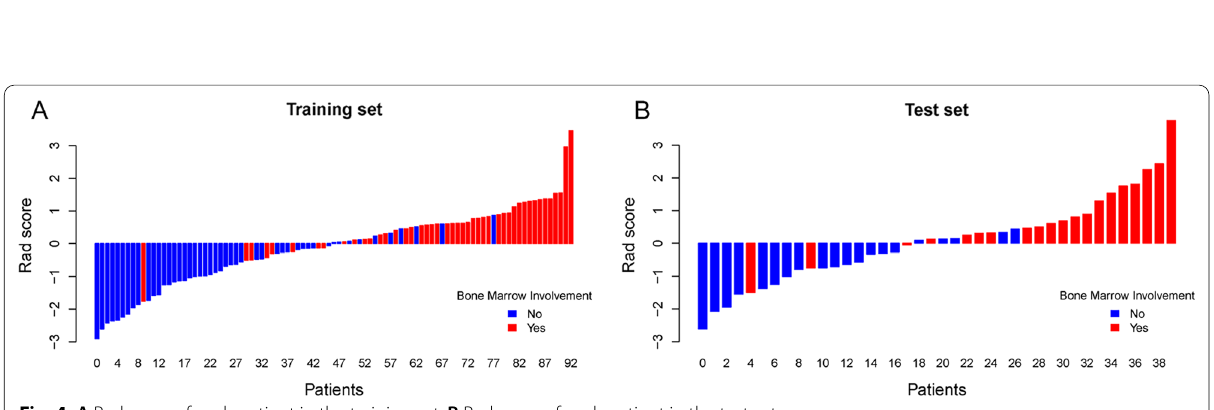
Fig. 4 A Rad score of each patient in the training set. B Rad score of each patient in the test set